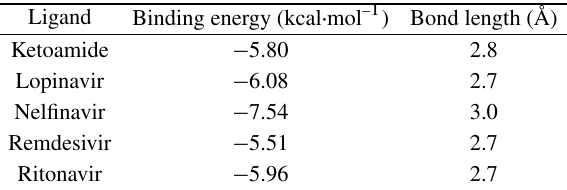
Table 1 Binding energy and bond length of COVID-19 protease inhibitors.